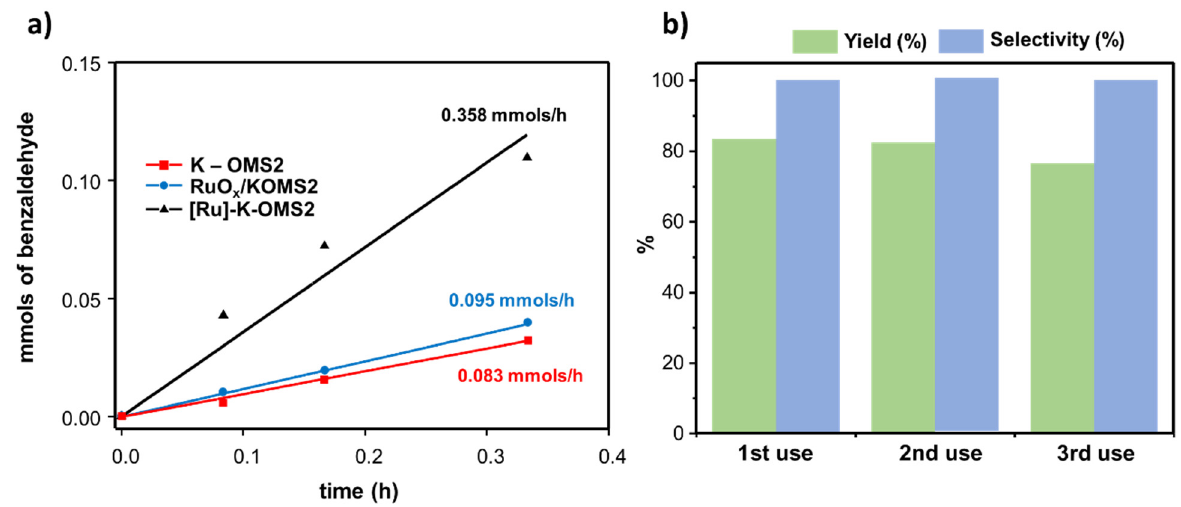
Figure 17. ( a ) Initial reaction rates ( r 0 ) calculated from the respective tangent lines for each catalyst, and ( b ) studies on recovery and reuse of the [Ru]–K–OMS–2 catalyst. Experimental data for both graphics can be found in [108].